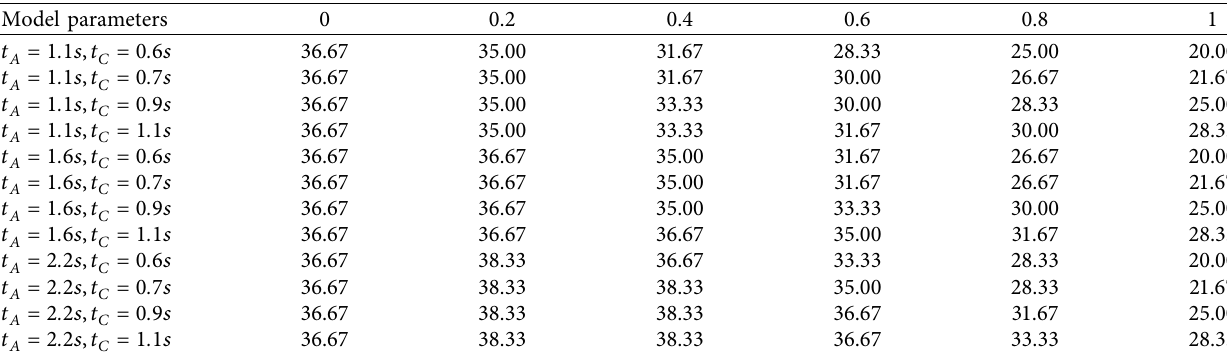
Table 7: Maximum congestion scale under different model parameters (unit: %). Model